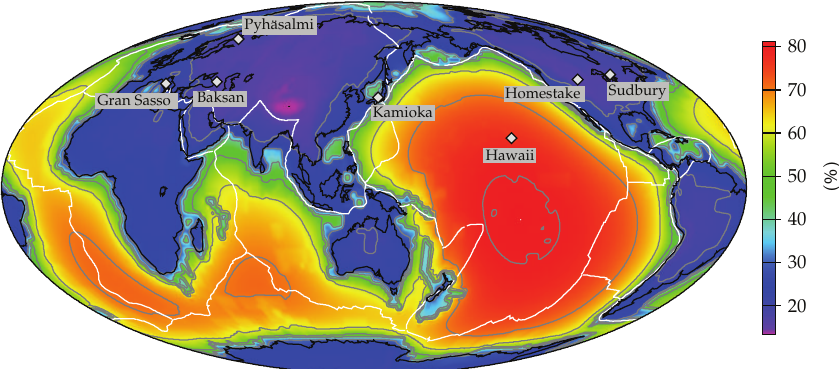
Figure 11: Ratio of mantle to total (cid:5) mantle (cid:7) crust (cid:6) geoneutrino signal as predicted from crustal and mantle models shown in Figures 8 and 10. See (cid:3) 69 (cid:4)